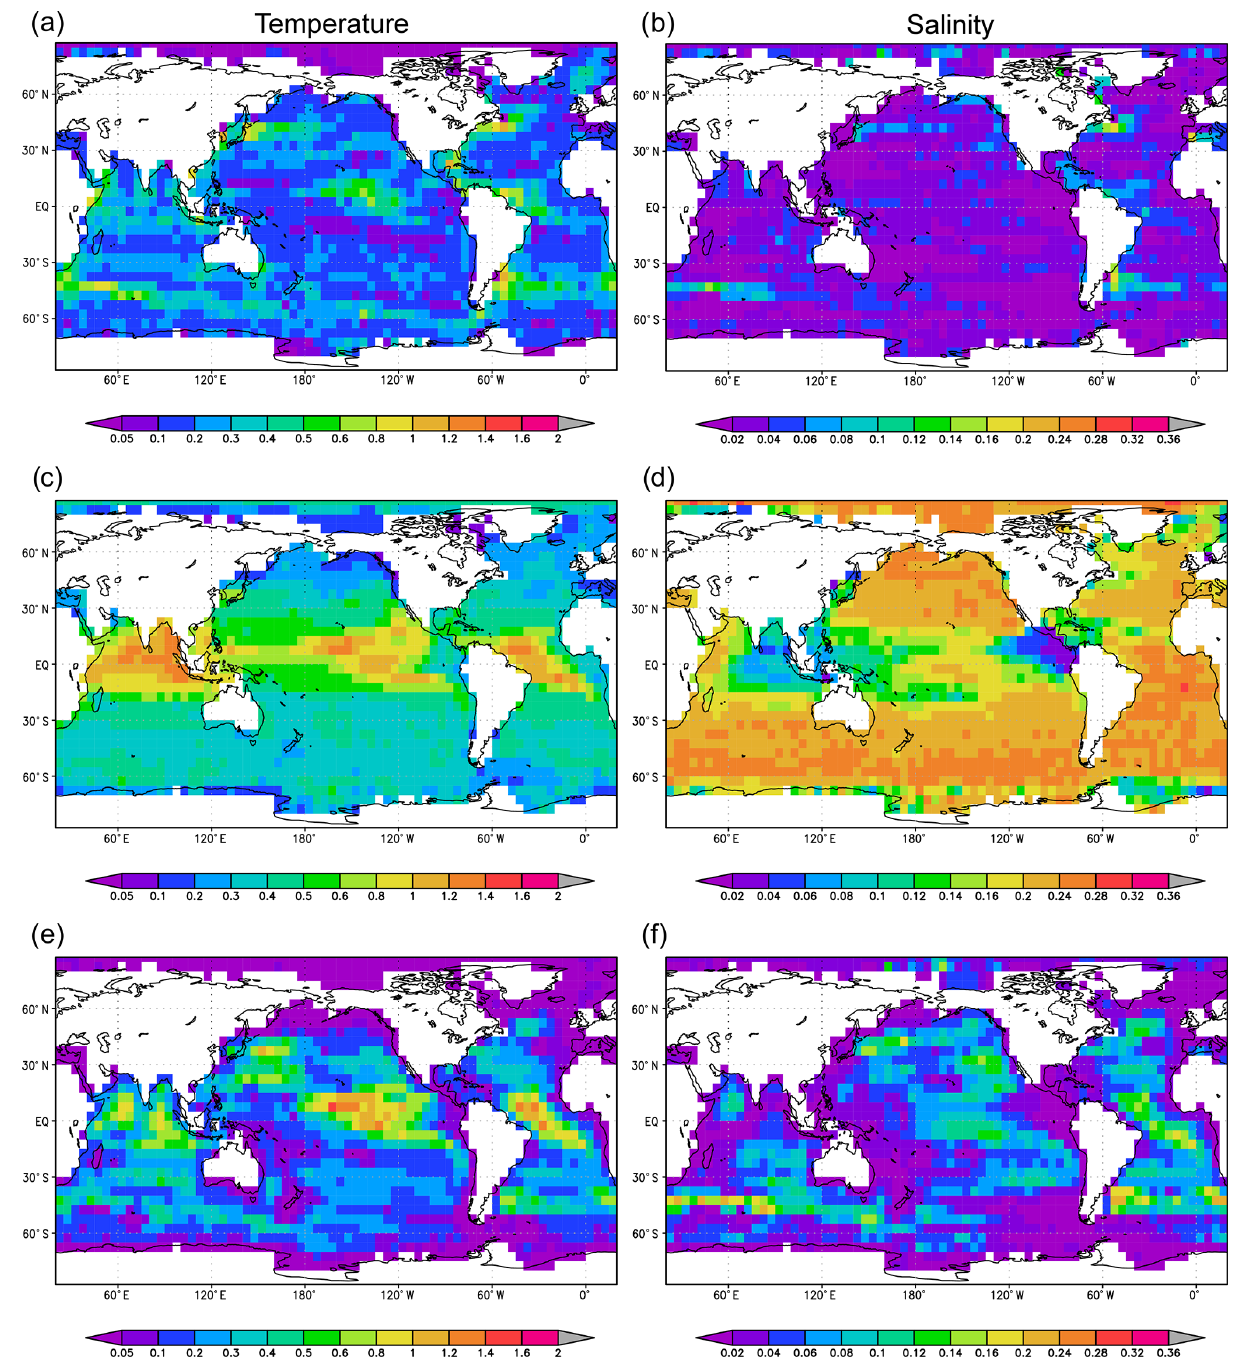
Figure 13. Maps of ORAS5 (a, c, e) temperature (in K) and (b, d, f) salinity (in psu) at 100m and as (a, b) ensemble spread, (c, d) specified background error (BGE) standard deviations and (e, f) diagnosed BGE standard deviations; ensemble spread is calculated using model background values from all five ORAS5 ensemble members. All diagnostics are averaged over the 2010–2013 period and binned and averaged into 5 ◦ × 5 ◦ long–lat